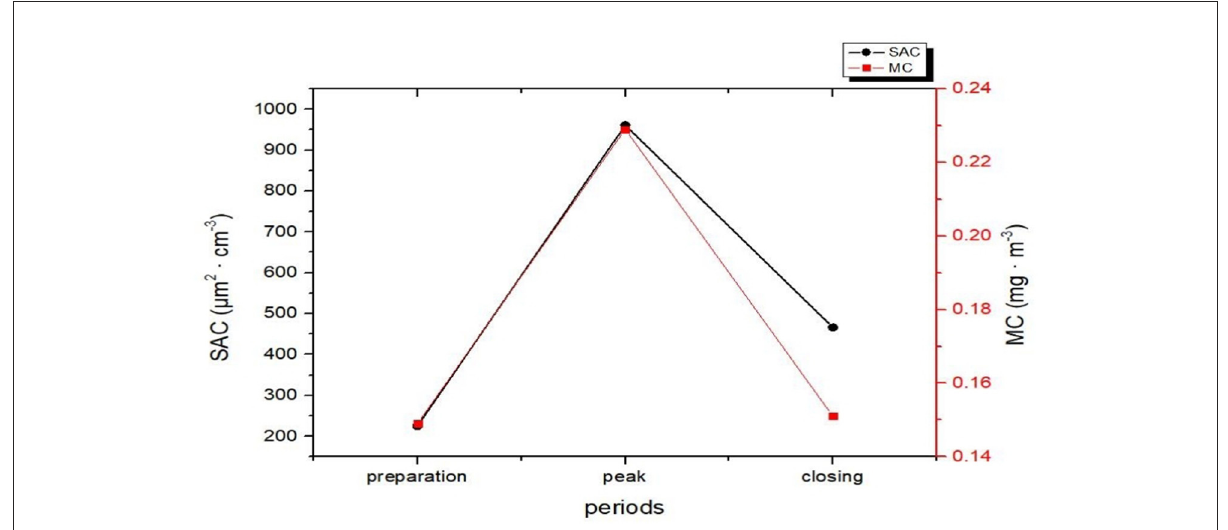
FIGURE4 Mean values of SAC 10 ∼ 500nm and MC 10 ∼ 500nm of particles at fried food posts in the Chinese kitchen in different